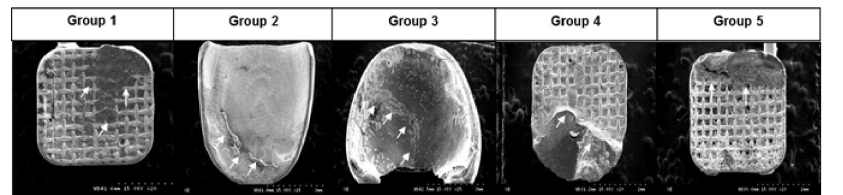
Fig 5. SEM imagines of bracket base after debonding. The resin cement remaining on the bracket base was pointed by the white arrows. The resin cement penetration within metal bracket mesh are shown in group 1, 4, and 5. Group 5 showed the most air voids compared with group 1 and 4. Group 2 showed a small amount on the bottom of bracket. Although a break line was evident, the resin cement completely covered all the surface of the bracket base in group 3. Group 1, preadjusted bracket; Group 2, Harmony; Group 3, Incognito; Group 4, Insignia; Group 5,